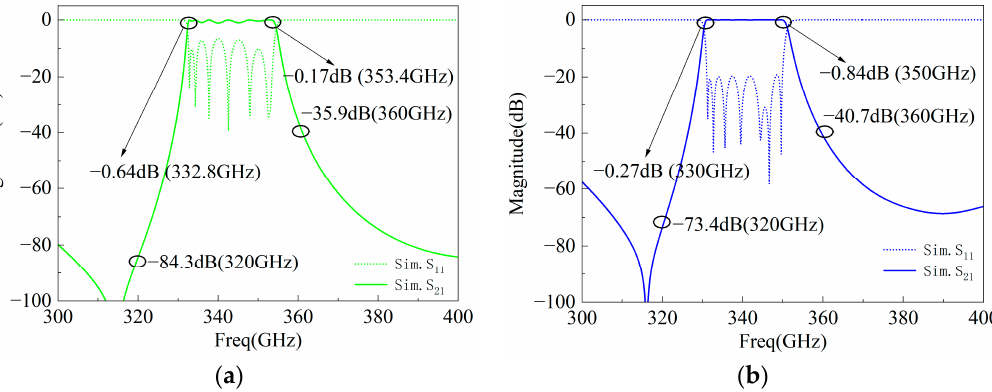
Figure 3. Simulation results of 340 GHz terahertz filter: ( a ) based on theoretical values; ( b ) based on HFSS optimization values.